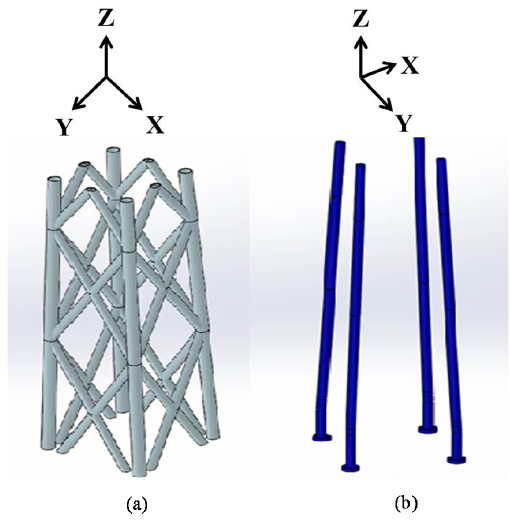
Appl. Sci. 2016 , 6 , 307 Figure 9. Growth Mass ( a ); and Flooded Legs ( b ). Figure 9. Growth Mass ( a ); and Flooded Legs ( b ).